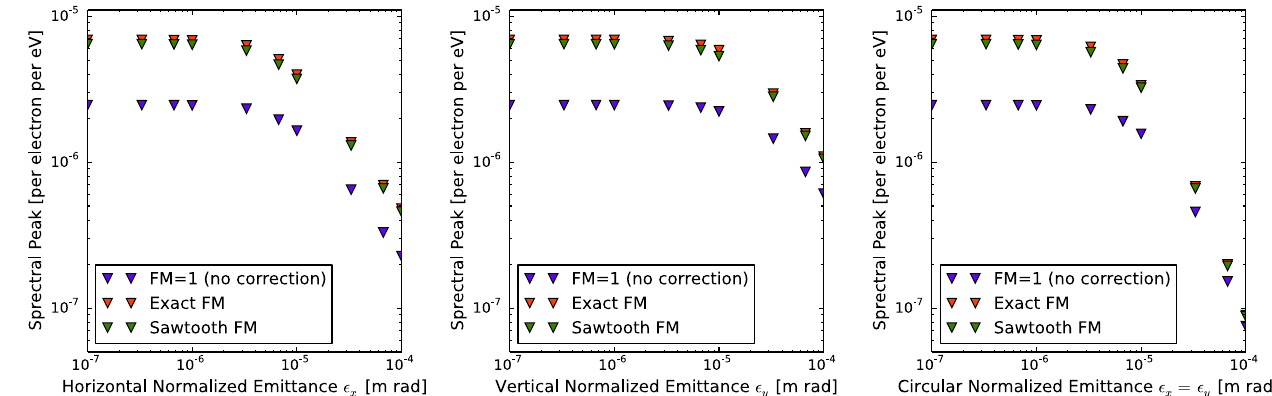
FIG. 9. Spectral peak as a function of normalized horizontal emittance (left), normalized vertical emittance (middle), and normalized circular emittance (right). These plots compare three different FM functions: uncorrected simulation (FM ¼ 1 ), the optimal chirping solution [11], and a sawtooth chirping function. The following parameters were used in the simulations: E e ¼ 23 MeV; Δ